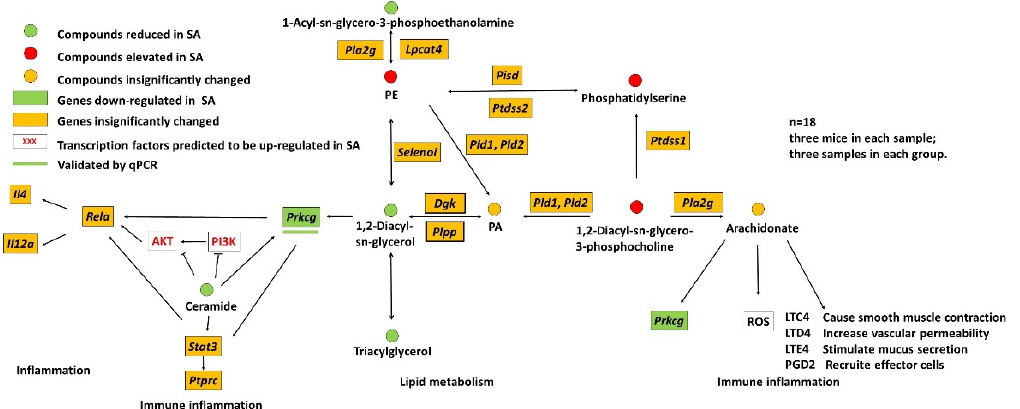
Figure 7. Transcriptome and lipidome integrated pathway diagram presents alterations of lipids and genes related to lipid metabolism and immune inflammation in SA spleen DCs. PE, phosphati- dylethanolamine; PA, phosphatidate acid.